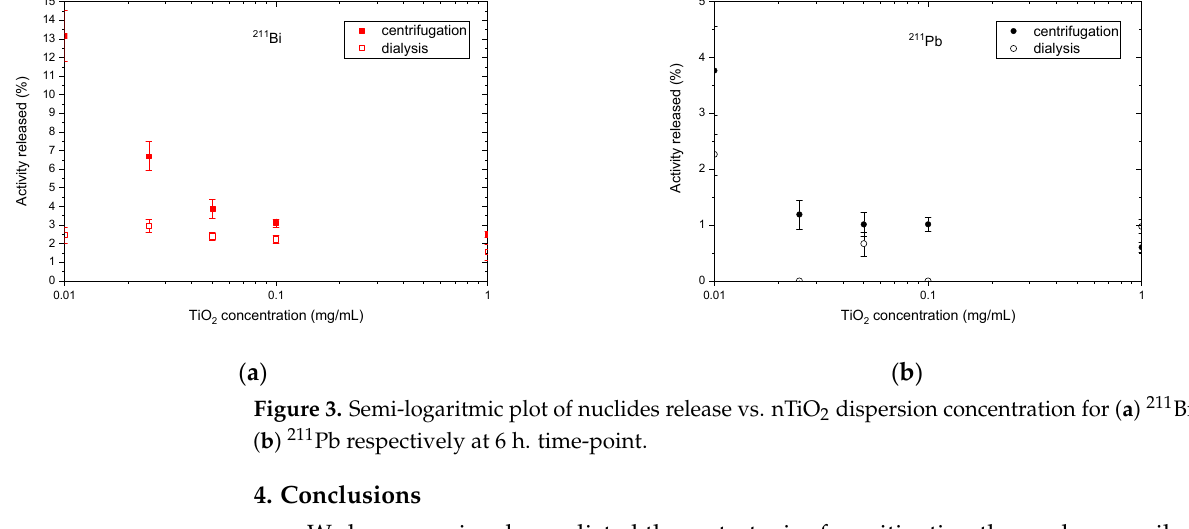
Figure 2. Nuclides release vs. time at ( a ) 1 mg/mL, ( b ) 100 µg/mL, ( c ) 50 µg/mL, ( d ) 25 µg/mL, ( e ) 10 µg/mL dispersion concentration using centrifugation and dialysis as phase separation methods.